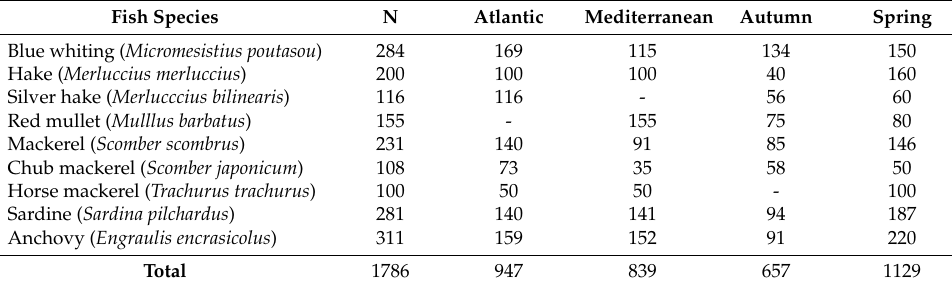
Table 5. Origin and season of capture of the sample.